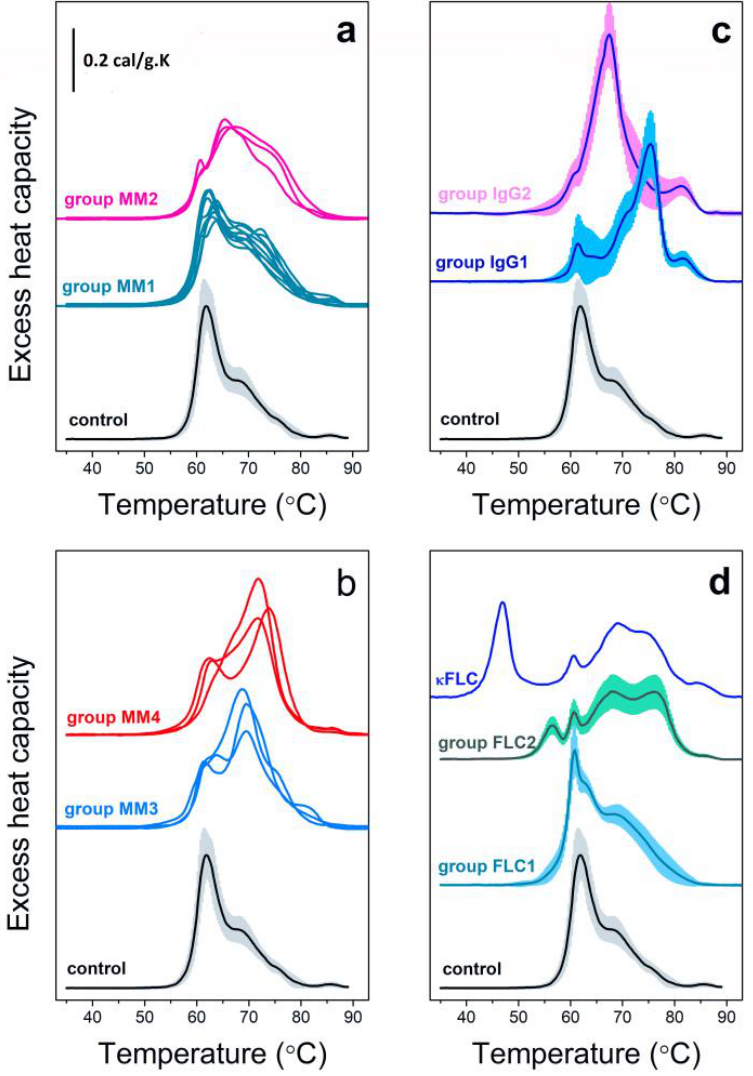
Figure 2. General calorimetric classification of MM cases. Average sets of DSC profiles of MM sera recorded for different MM types (129 cases of IgG [5,37,40], 52 cases of IgM [5,37,38,40], 44 cases of IgA [5,37,39,40], 75 cases of FLC [5,35 – 37,40] and 296 cases NS [5,37,40] MM) are presented; the combination in groups MM1-MM4 is based on number of peaks, similarity in shape and on the position of the main peak ( a , b ). For clarity only the average thermograms, without the corresponding SD, are presented. Specific MM groups for 24 IgG MM cases ( c ) and 23 FLC MM cases ( d ) (mean ± SD), as well as unique FLC case differ from the rest of investigated MM cases (( d ), blue line). A total of 23% of the FLC cases also exhibit specific features, i.e., high-amplitude sharp transition at 61 ◦ C (set FLC1) or low amplitude transition at 57 ◦ C (set FLC2). While the nature of the 61 ◦ C transition is not clear yet, the origin of the 57 ◦ C peak can be ascribed to FLC denaturation considering: (i) the high correlation between the amplitude of this transition and FLC serum level, (ii) the close coincidence of the transition temperature